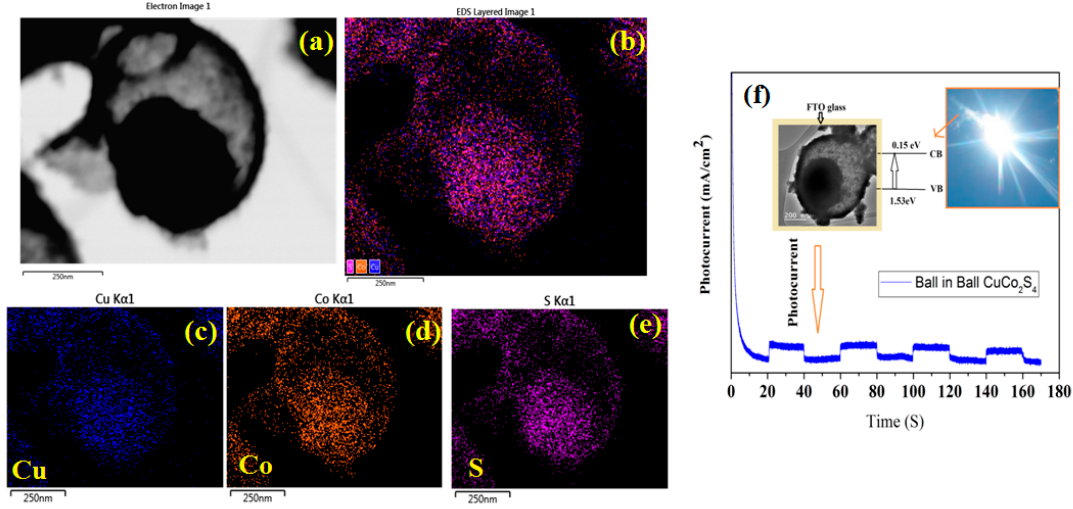
Figure 3. ( a – e ) EDS mapping ( f ) Photocurrent studies of CuCo 2 S 4 yolk-shell structure.